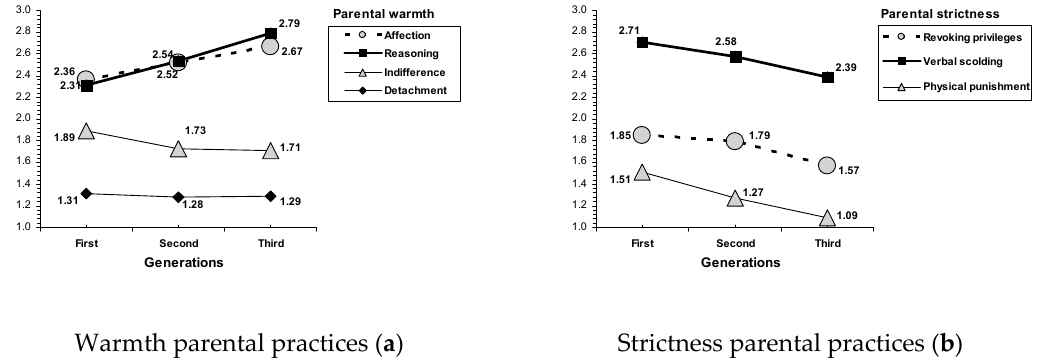
Figure 1. Parenting across generations for parental practices of ( a ) warmth, and ( b ) strictness.